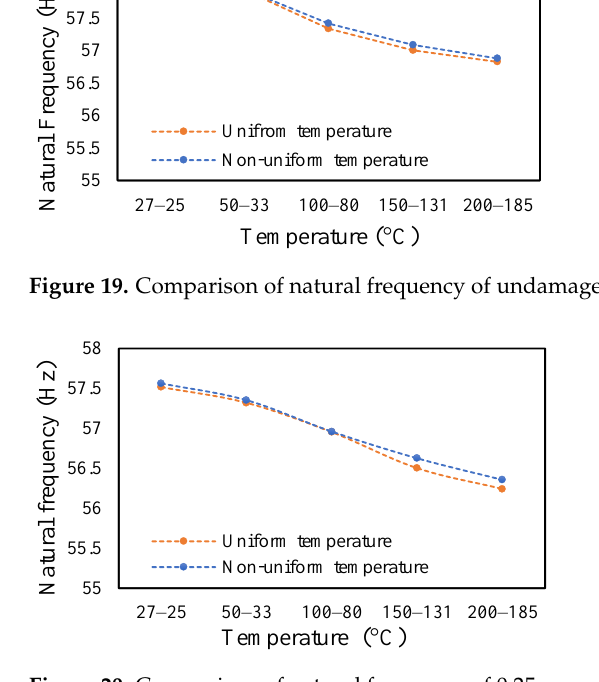
Figure 20. Comparison of natural frequency of 0.25 mm crack depth ramped at 2 °C/min.